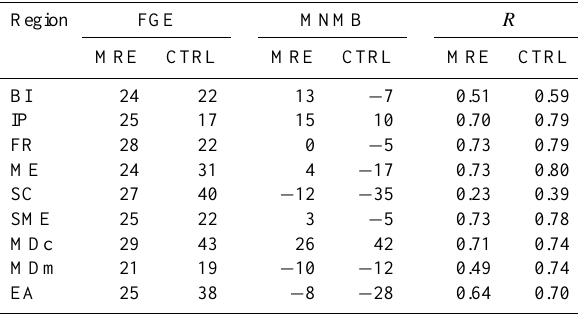
Table 3. Annual statistics of near-surface ozone for the MACC re- analysis (MRE) and the control run (CTRL) over the different Eu- ropean subregions for the common period from 2003 to 2010. FGE and MNMB are expressed in